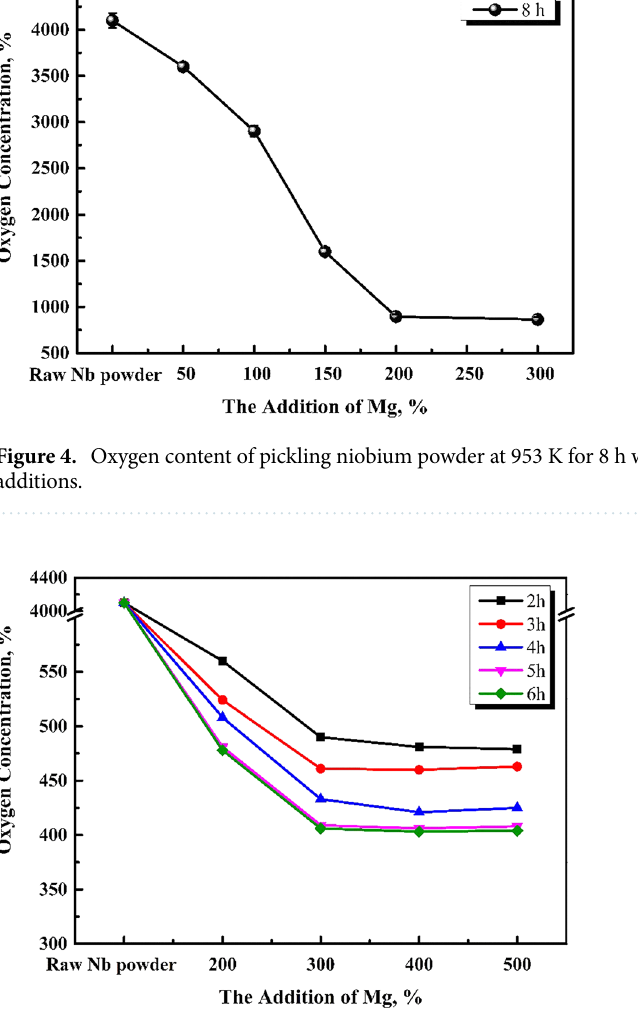
Figure 5. Effect of magnesium addition and reduction time on the oxygen content of pickling niobium powder at 1093 K.